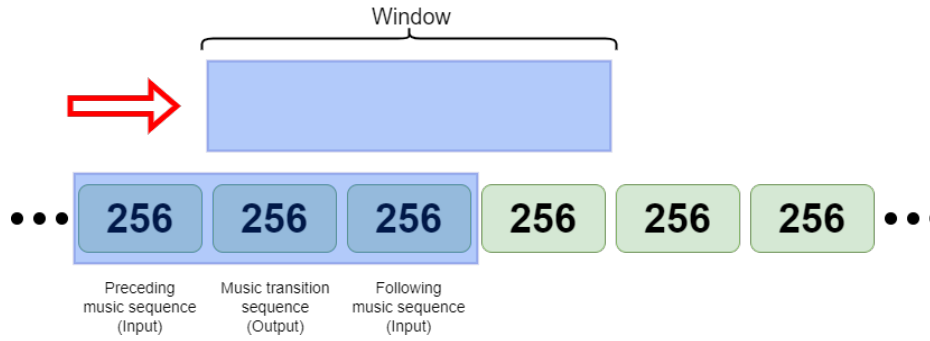
Figure 9. Data processing of training samples for model construction.